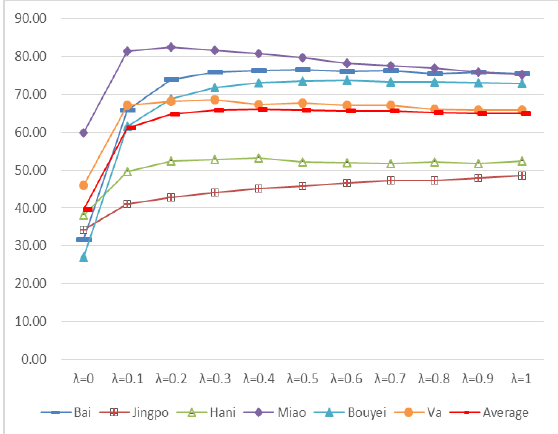
Fig.2. The performance of each nationality with differe nt λ